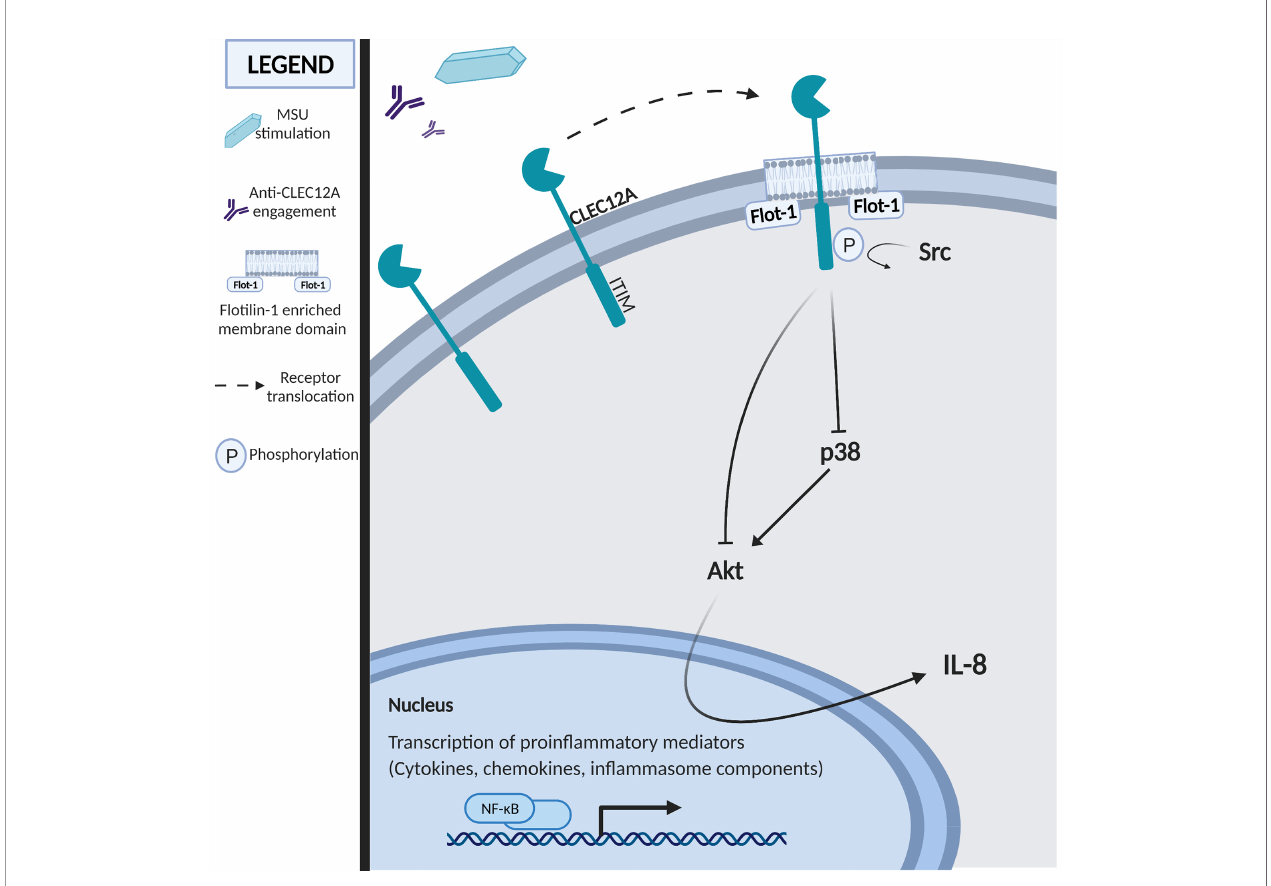
FIGURE 7 | Schematic representation of the MSU-induced signaling pathways negatively regulated by CLEC12A upon its translocation to fl otillin-rich membrane domains and its